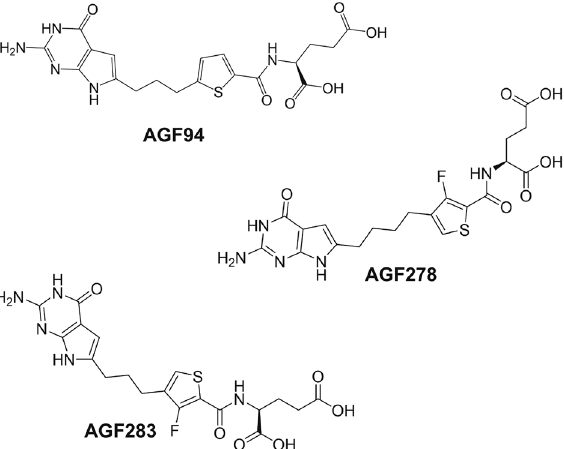
Figure 1. Structures of 6-substituted pyrrolo[2,3- d ]pyrmidine inhibitors of de novo purine nucleotide biosynthesis. Structures are shown for AGF94 , AGF278 , and AGF283 , selective substrates for FRs and PCFT over RFC, and inhibitors of the folate-dependent purine biosynthetic enzyme GARFTase 21,22